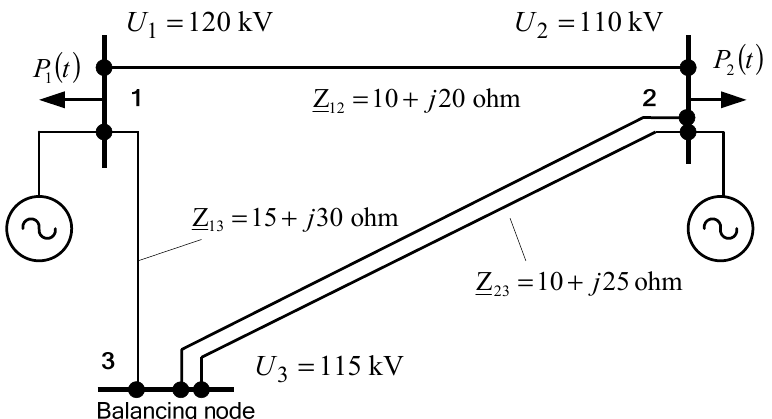
Figure 2. Diagram of an electric power system.